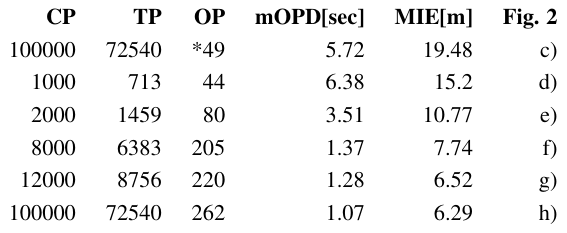
Table 1: Bundle adjustment of HRSC images: different number of tie points (TP) result in different mean orientation point distance (mOPD), * with cOPD, else vOPD In Fig. 2 the forward intersection error for different numbers of tie points is shown with color-coded error maps. The plots were created by using the same, independently obtained set of about